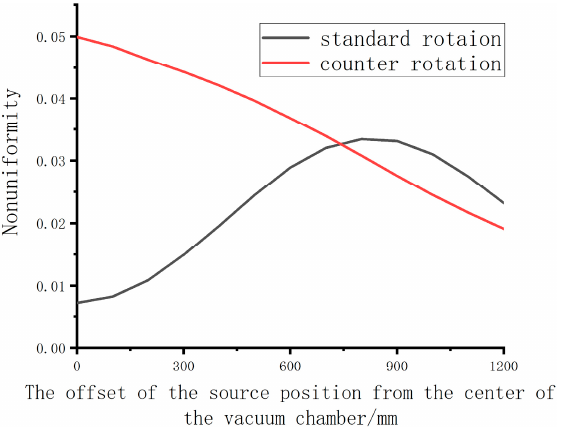
Figure 6. Theoretical nonuniformity over the radius of the planet from 0–350 mm versus the offset of the source position from the center of the vacuum chamber.